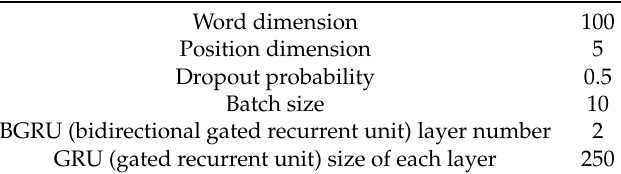
Table 6. Hyper-parameter